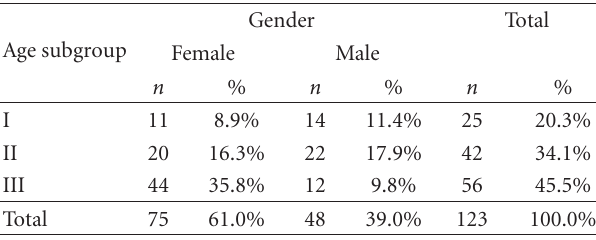
Table 3: Control group (for explanation of age-subgroups, see Table